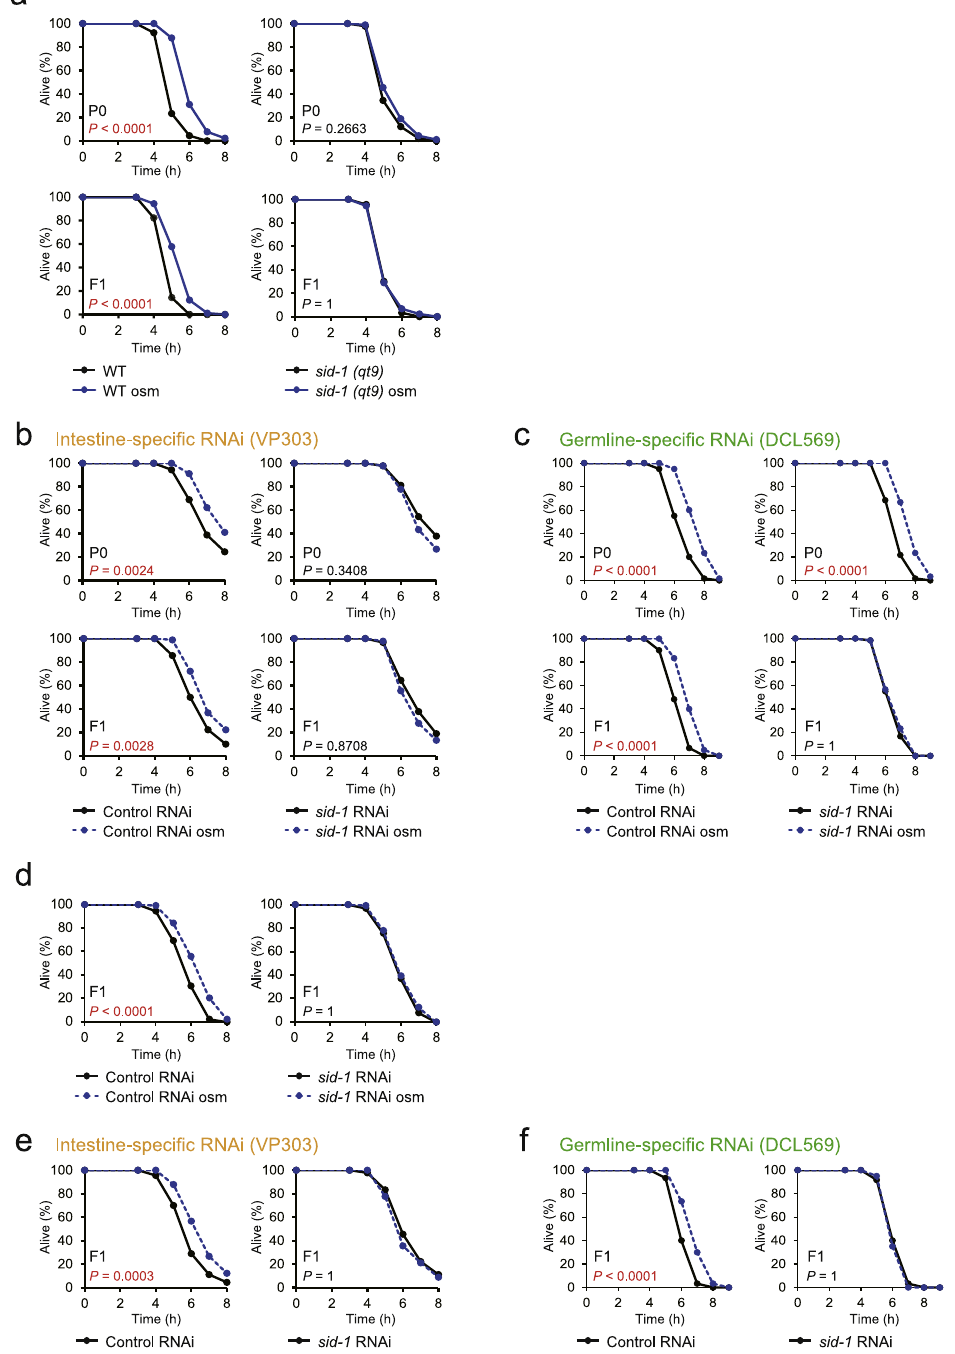
Fig. 3 Intertissue transport of small RNAs is necessary for both the acquisition and the inheritance of hormesis. a Oxidative stress resistance (1.8 mM H 2 O 2 ) of WT (left) and sid-1 mutants (right) in the P0 generation (upper) and the F1 generation (lower). b Oxidative stress resistance (2.5 mM H 2 O 2 ) of intestine-speci fi c RNAi mutants (VP303) treated with RNAi (left, control RNAi; right, sid-1 RNAi) in the P0 generation (upper) and the F1 generation (lower). c Oxidative stress resistance (2.0 mM H 2 O 2 ) of germline-speci fi c RNAi mutants (DCL569) treated with RNAi (left, control RNAi; right, sid-1 RNAi) in the P0 generation (upper) and the F1 generation (lower). d Oxidative stress resistance (2.0 mM H 2 O 2 ) of the F1 descendants, which were derived from the stressed P0 parents and treated with RNAi (left, control RNAi; right, sid-1 RNAi). e Oxidative stress resistance (2.5 mM H 2 O 2 ) of the F1 descendants in intestine-speci fi c RNAi mutants, which were derived from the stressed P0 parents and treated with RNAi (left, control RNAi; right, sid-1 RNAi). f Oxidative stress resistance (2.0 mM H 2 O 2 ) of the F1 descendants in germline-speci fi c RNAi mutants, which were derived from the stressed P0 parents and treated with RNAi (left, control RNAi; right, sid-1 RNAi). Two or three independent experiments are integrated into each survival curve ( n = 60 or 90). Mean survival time and statistics are presented in Supplementary Data 1. P values were calculated by log-rank test with Bonferroni